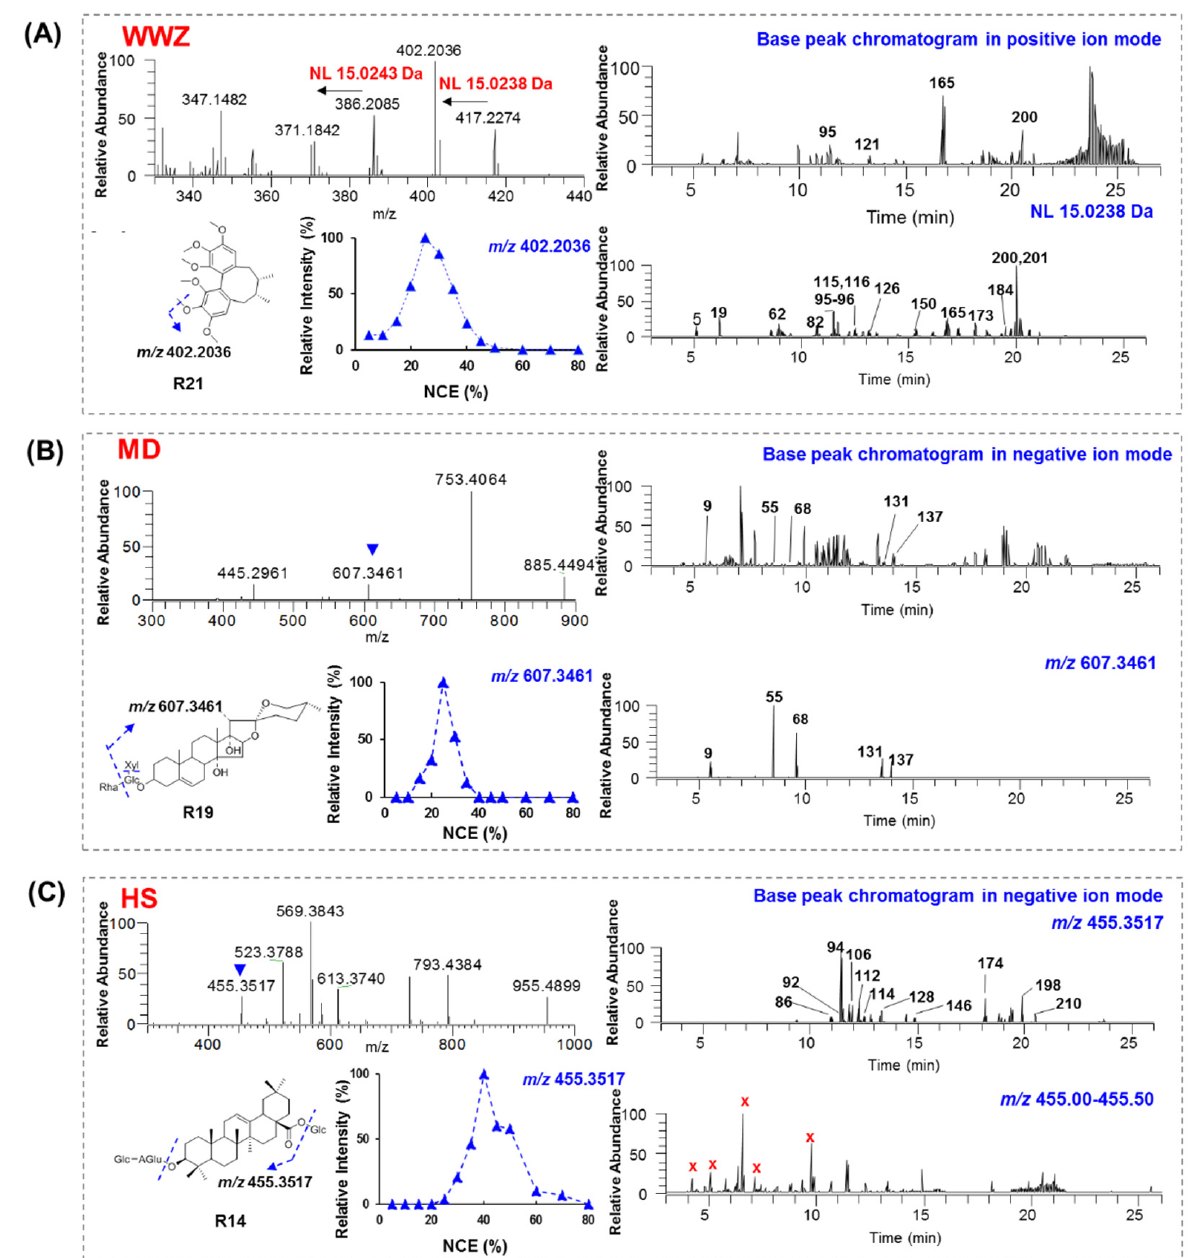
Figure 1. Neutral losses and key product ions were used to identify different types of compounds in SMS. ( A ) The MS/MS spectrum, fragmentation pathway, and optimization of NCE for R21 , as well as the filtering of NL 15 Da in YQFMI; ( B ) the MS/MS spectrum, fragmentation pathway, and optimization of NCE for R19 , as well as the filtering of the product ion at m / z 607.3461 in YQFMI; ( C ) the MS/MS spectrum, fragmentation pathway, and optimization of NCE for R14 , as well as the filtering of the product ion at m / z 455.3517 in YQFMI. “X” represents for the false-positive